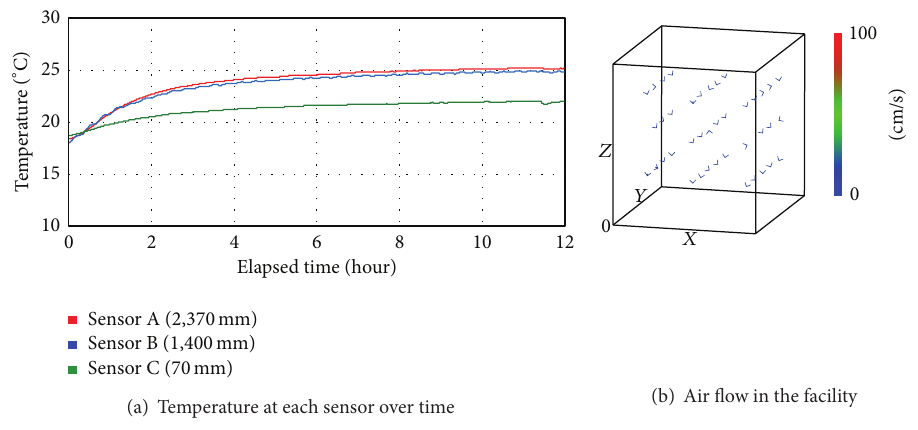
Figure 3: Temperature and air flow in the condition of Case 1.